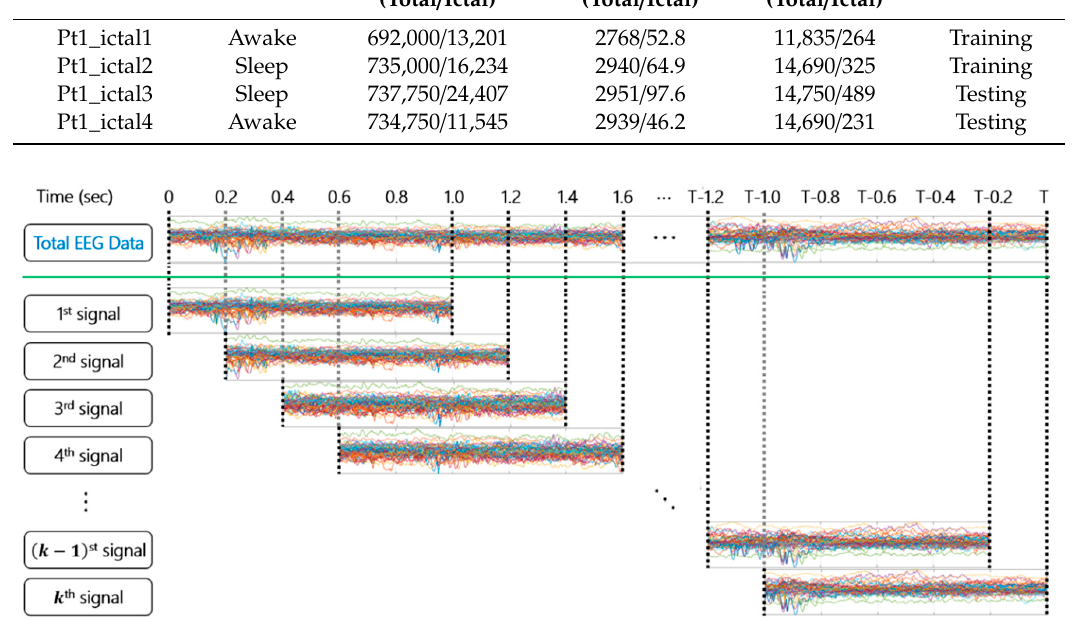
Figure 4. Sampling process for training data. A total of k signals are presented above. Each EEG signal was obtained for one second of time lapse, and it consists of a total of 250 uniformly chosen snapshots from 2000 snapshots for each signal. Note that after the i th EEG signal is obtained, the next EEG signal, the ( i + 1 ) st EEG signal is then obtained with 0.2 s of waiting time. Therefore, the adjacent EEG signals have data in common for 0.8 s, equivalently, 200 snapshots.